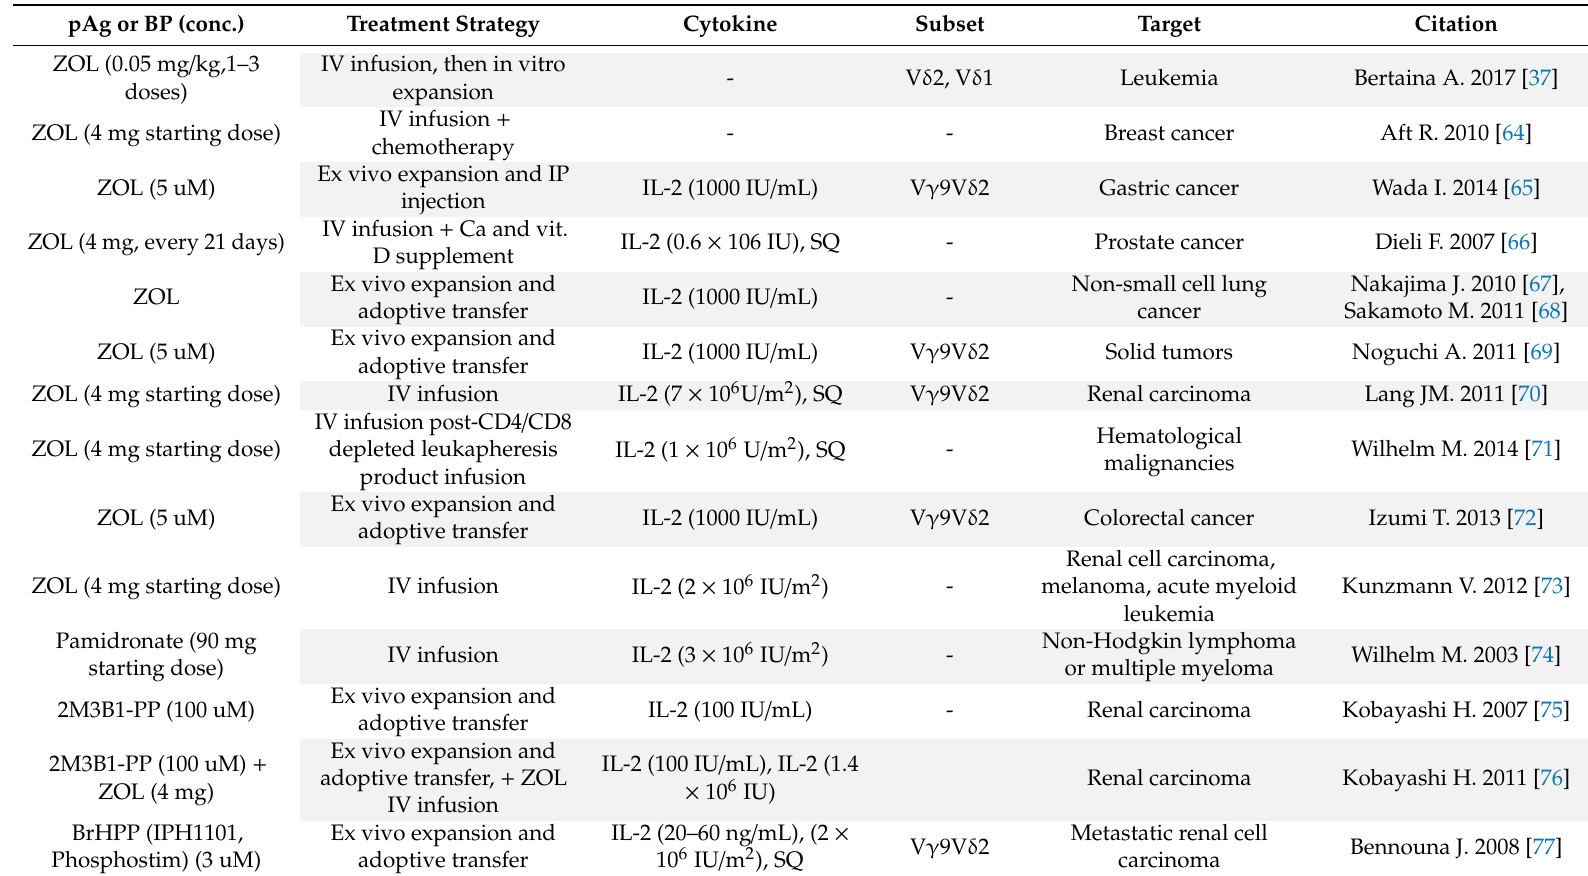
Table 2. Clinical studies using phosphoantigens or bisphosphonates for γδ T cells activation and expansion. pAg or BP